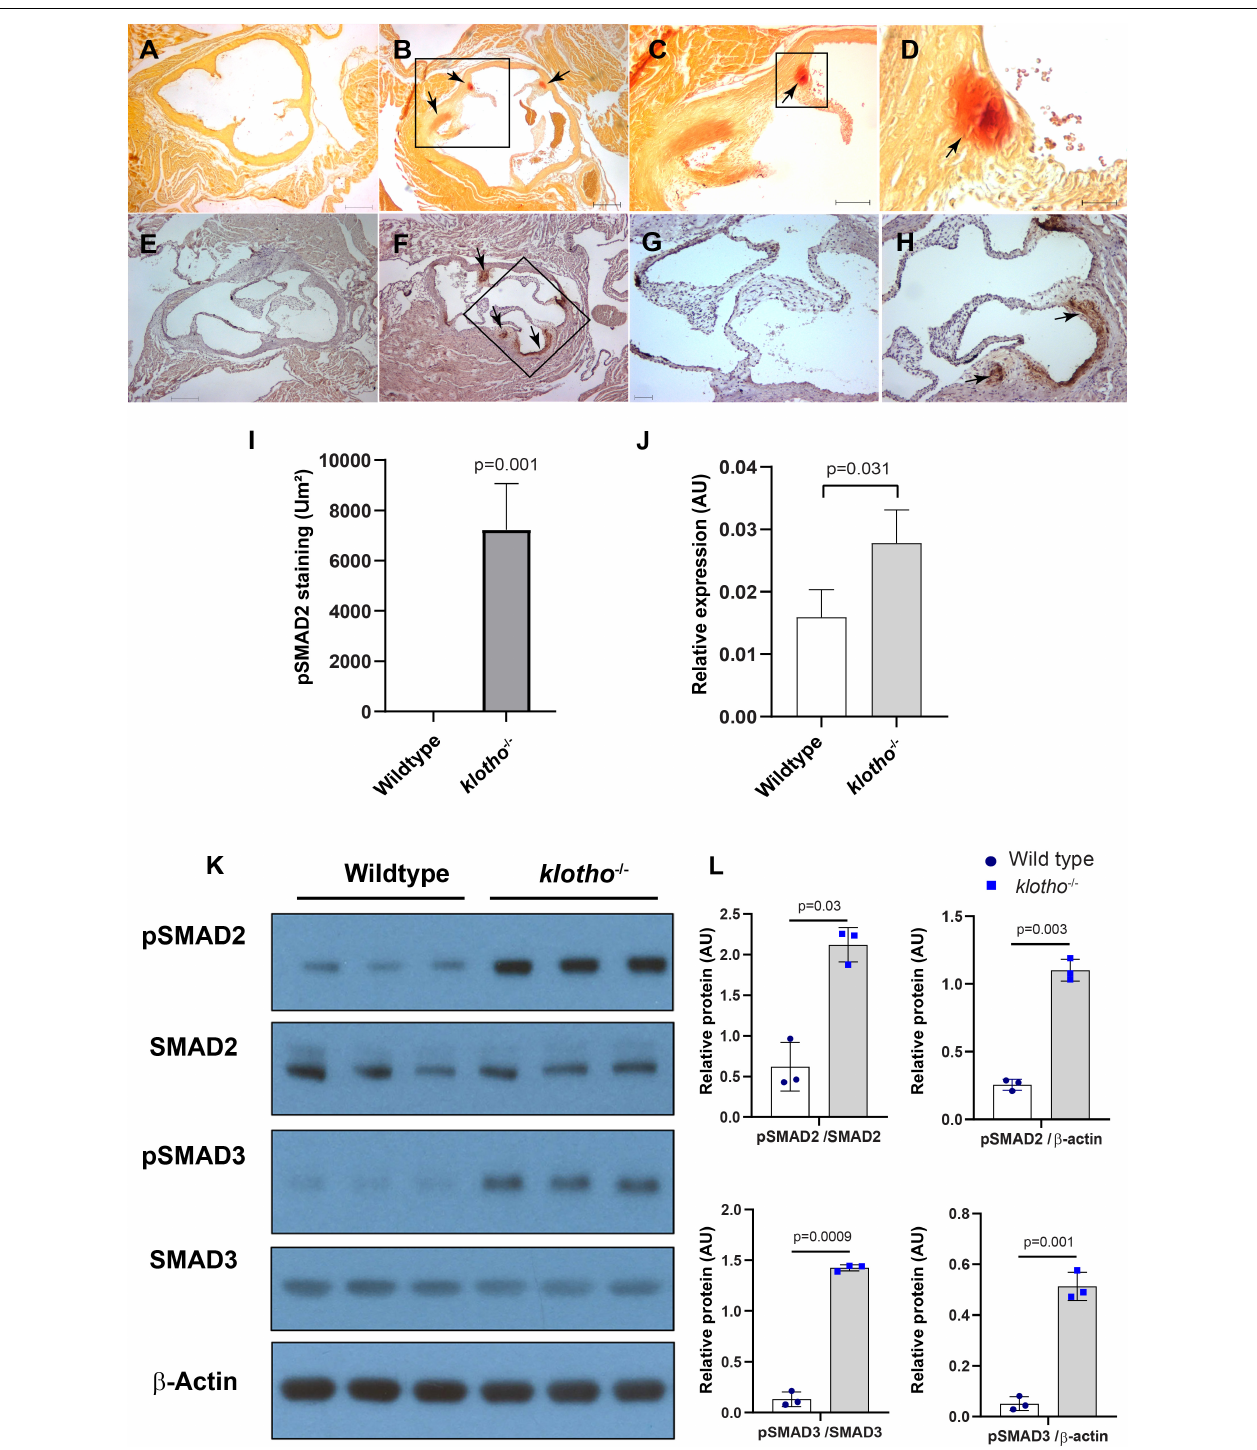
FIGURE 1 | The klotho ( Kl ) genetic deletion leads to calcification in the aortic valve hinge and annulus with upregulation of Tgfb1 and TGF β -dependent SMAD2 signaling in 10–12-week-old mice. (A–D) Alizarin red staining of wild-type (A) and Kl − / − (B–D) mice. Scale bars = (A–B) 200 µ m; (C) 100 µ m; (D) 50 µ m. (E–I) Immunohistochemistry showing localized pSMAD2 levels in AV hinge and aortic annulus of wild-type (E,G) and Kl − / − (F,H) . The pSMAD2-stained area was quantified using NIH Image J software (I) . (J) qPCR study to quantify Tgfb1 expression in the pooled and micro-dissected tissue samples of AV and annulus from wild-type and Kl − / − mice. (K) Western blotting analyses showing levels of phosphorylated SMADs (p SMAD2, pSMAD3), total SMADs (SMAD2, SMAD3), and β -actin in micro-dissected and pooled tissue samples containing AV and annulus from wild-type and Kl − / − mice. (L) Densitometric analysis quantifying band intensities of western blots. The densitometry graphs of pSMAD2 and pSMAD3 were normalized with total or non-phosphorylated form of the proteins or β -actin. Values indicate mean ± SD, and significant “ p -values” between wild-type and Kl − / − groups were given on the top of histograms. Frontiers in Cardiovascular Medicine |